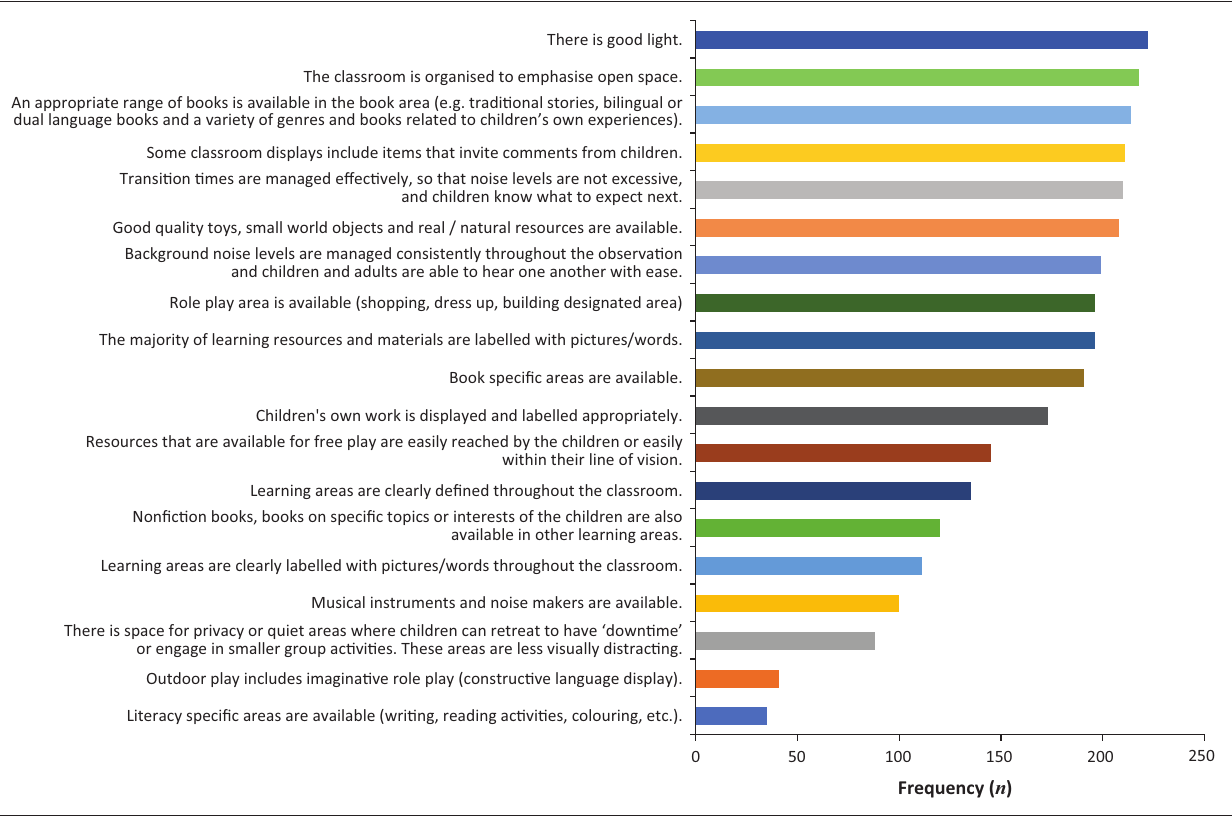
FIGURE 2: Frequency of items observed – Language-learning